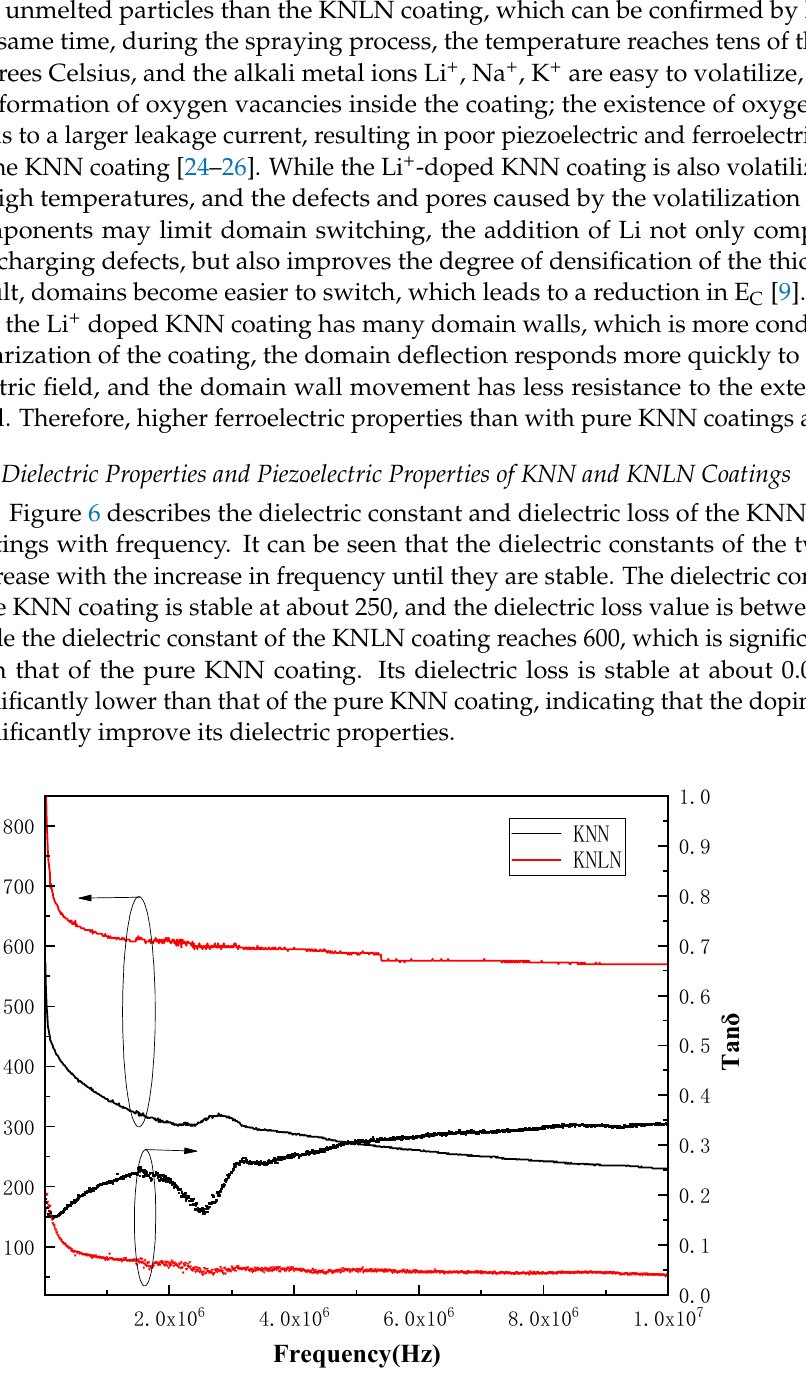
Figure 6. Plots of dielectric constant and loss versus frequency for KNN and KNLN coatings.